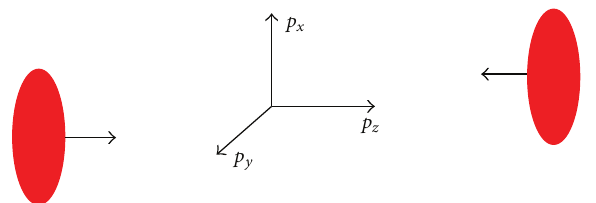
Figure 1: Schematic sketch of momentum space in